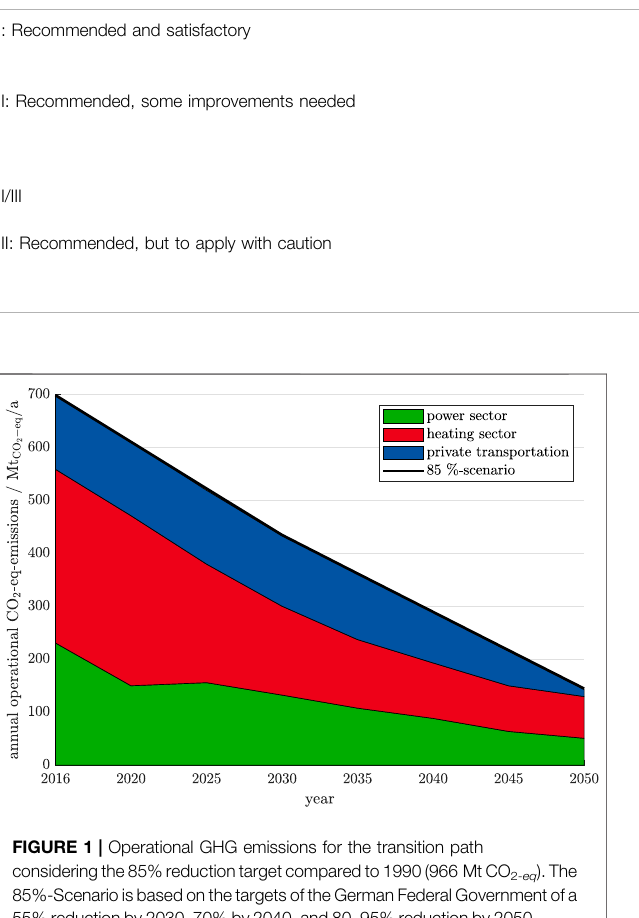
TABLE 1 | Considered environmental impacts in SecMOD following the recommendation of the European Commission ’ s Joint Research Centre in the European context, sorted by their quality level (JRC European Commission, 2011; Castellani et al., 2018). Quality level